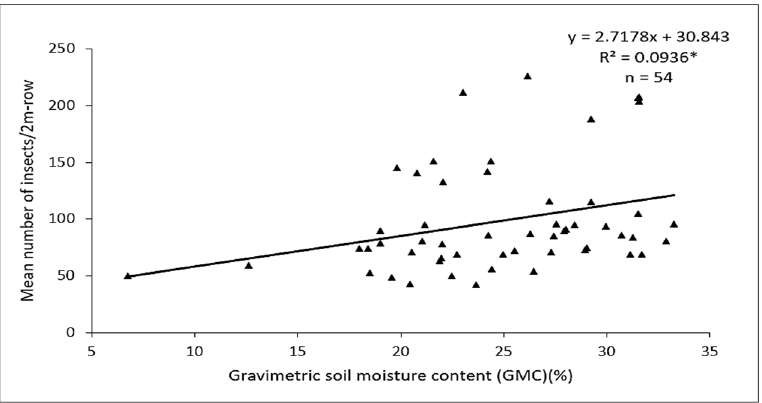
Figure 6. Regression line and equation showing the relationship between gravimetric soil moisture content (GMC) and D . glabrata population in 2018. * indicates significant regression coefficient at p < content (GMC) and D. glabrata population in 2018. * indicates significant regression coe ffi cient at 0.05. p <